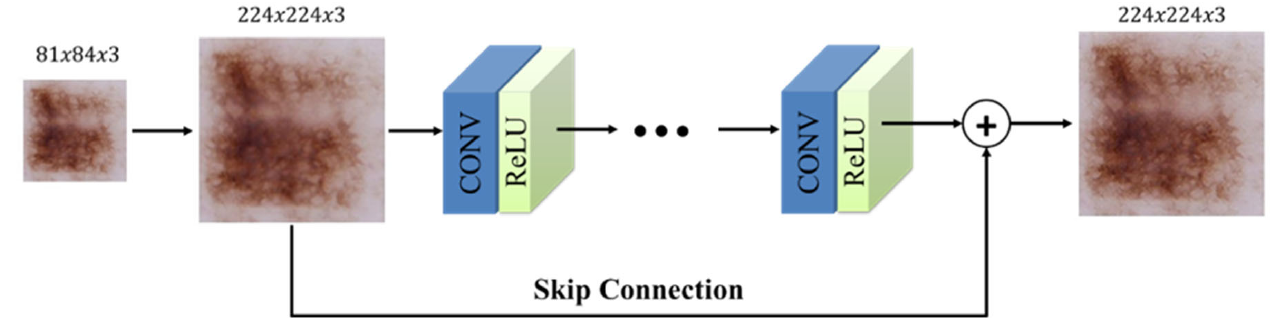
Figure 3. The structure of VSDR architecture [47].